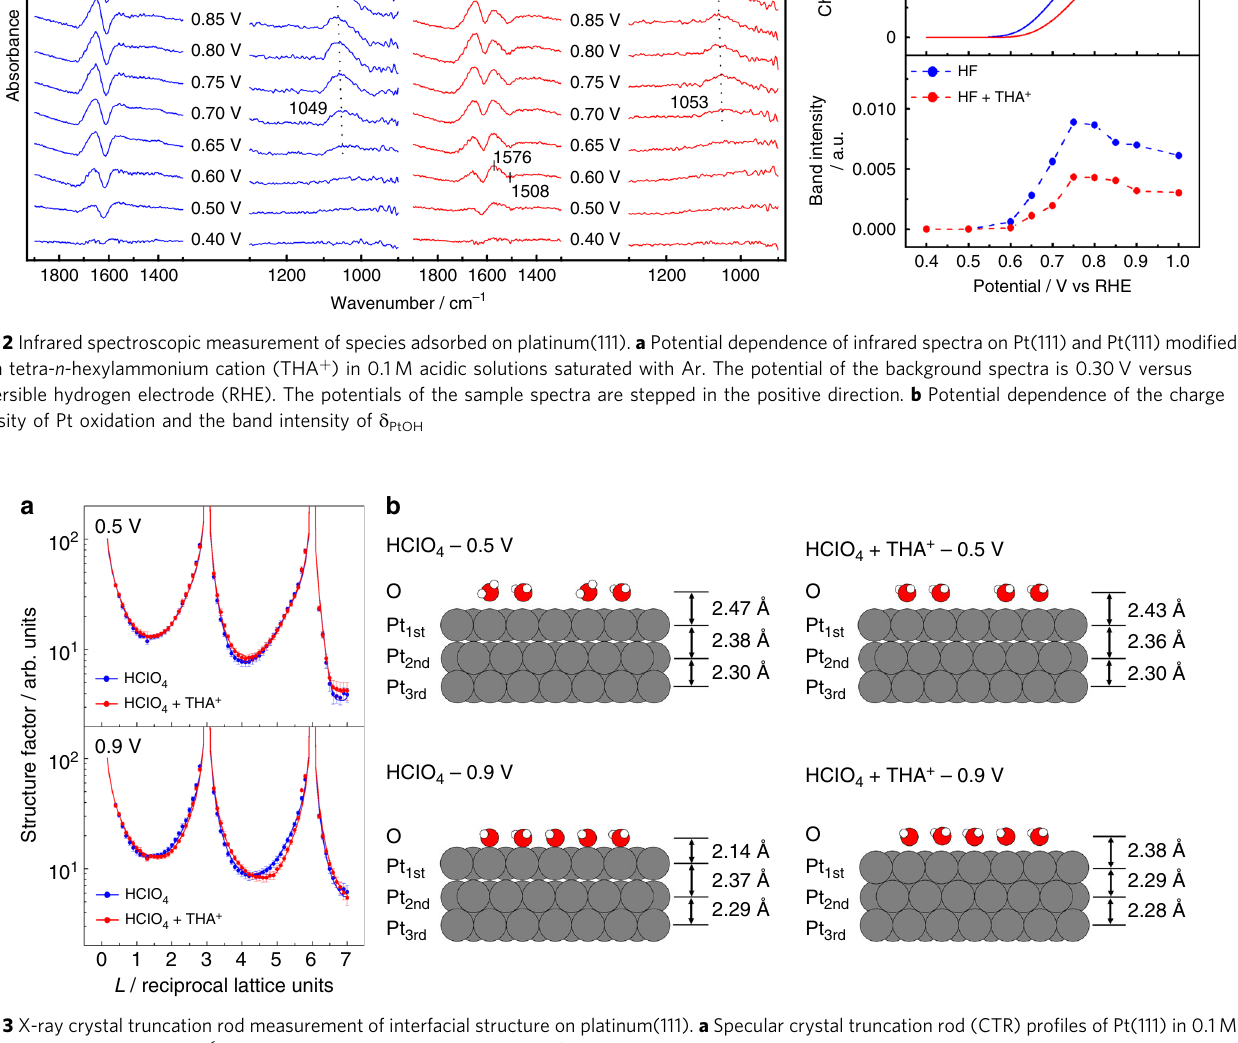
Fig. 3 X-ray crystal truncation rod measurement of interfacial structure on platinum(111). a Specular crystal truncation rod (CTR) pro fi les of Pt(111) in 0.1 M HClO 4 with and without 10 − 6 M tetra- n -hexylammonium cation (THA + ) saturated with Ar at 0.50 V and 0.90 V versus reversible hydrogen electrode (RHE). The dots are the data points and the solid lines are the structure factors calculated using the optimized model. b Schematic models of the interfacial structure